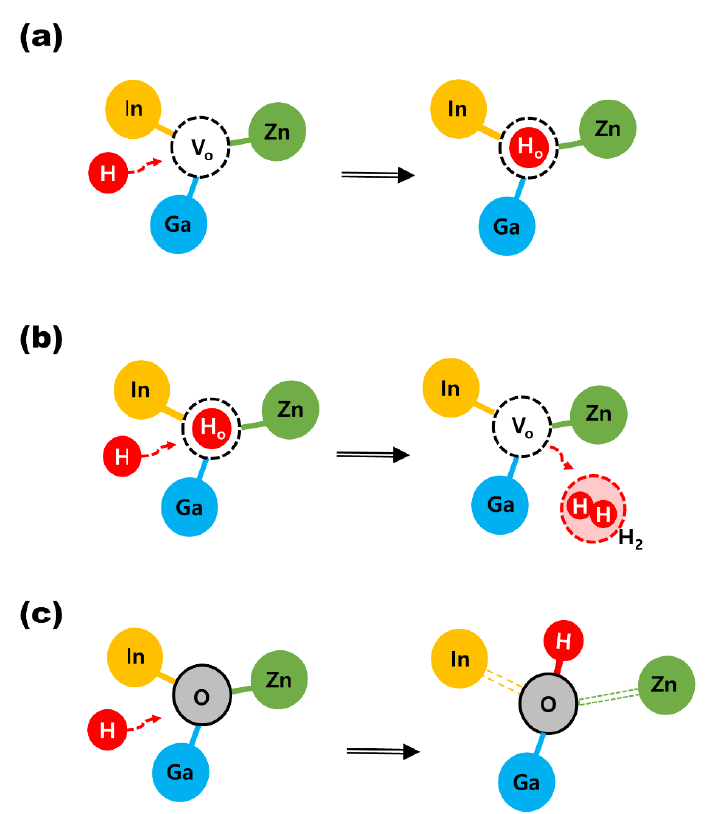
Figure 4. Schematic structure for the hydrogen and oxygen migration process for cases involving ( a ) trapped hydrogen in oxygen-deficient state, ( b ) unbound hydrogen, and ( c ) weak bonding of In and Zn with oxygen bound to hydrogen.